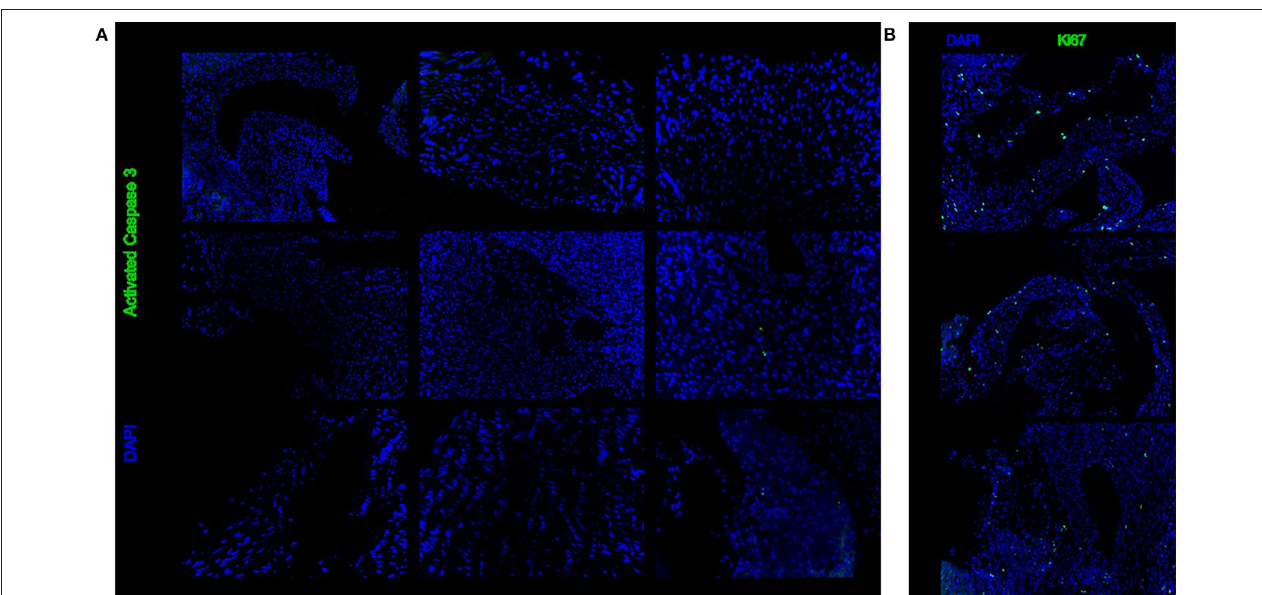
FIGURE 4 | Representative sections stained with immunohistochemistry for activated caspase 3 (A) or Ki67 (B) . There is no difference between 6, 24, and 48h of cold storage.